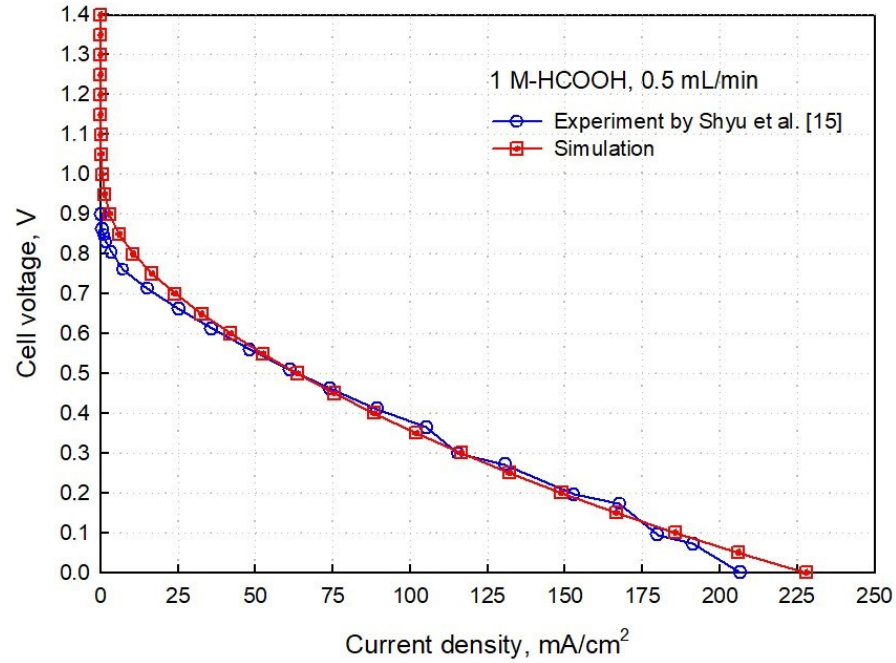
Figure 3. Performance of I – V curve comparison between the experimental data (Shyu et al., 2015) [15] vs. simulation (1.0 M-HCOOH, 0.5 mL/min).